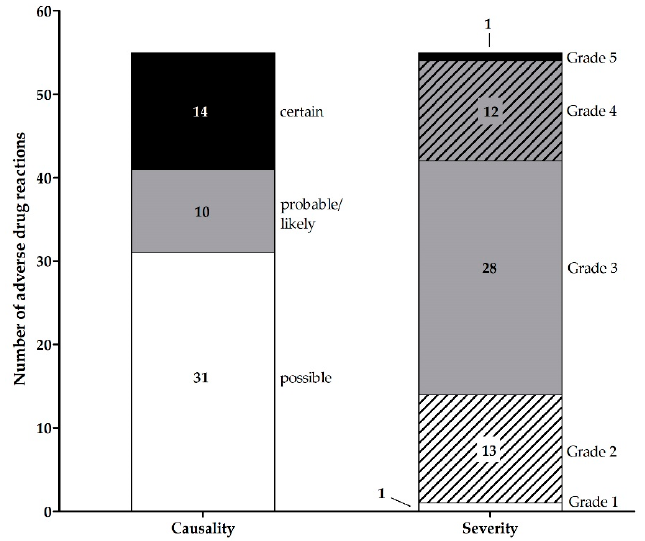
Figure 4. Number of OAT-related adverse drug reactions associated with hospitalizations, stratified for causality (according to WHO-UMC) and severity (according to CTCAE) within AMBORA. Abbreviations: CTCAE, Common Terminology Criteria for Adverse Events; OAT, oral anticancer treatment; WHO-UMC, World Health Organization Uppsala Monitoring Centre system.